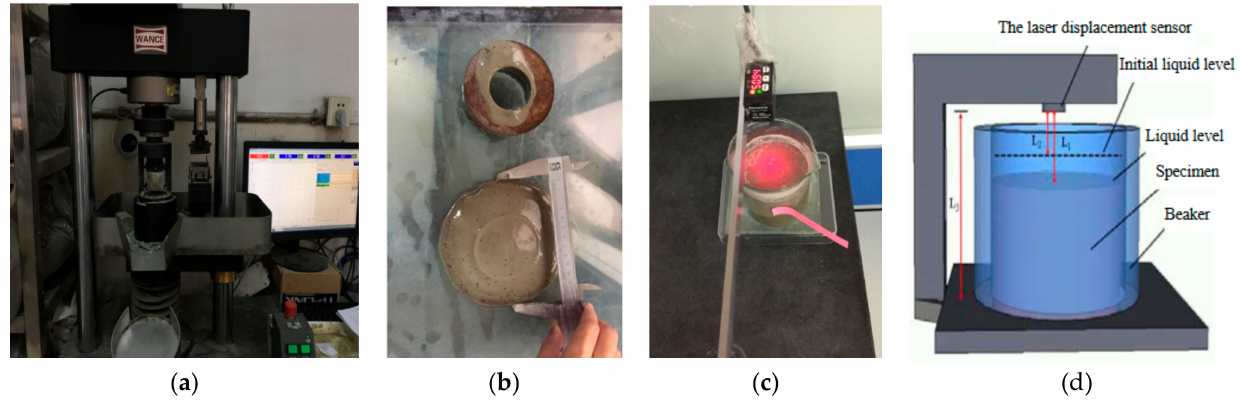
Figure 2. Physical diagrams of the orthogonal test. ( a ) Uniaxial compressive strength test; ( b ) fluidity test; ( c ) volume growth rate of the grouting body test; ( d ) Schematic diagram of the volume growth rate of the grouting body